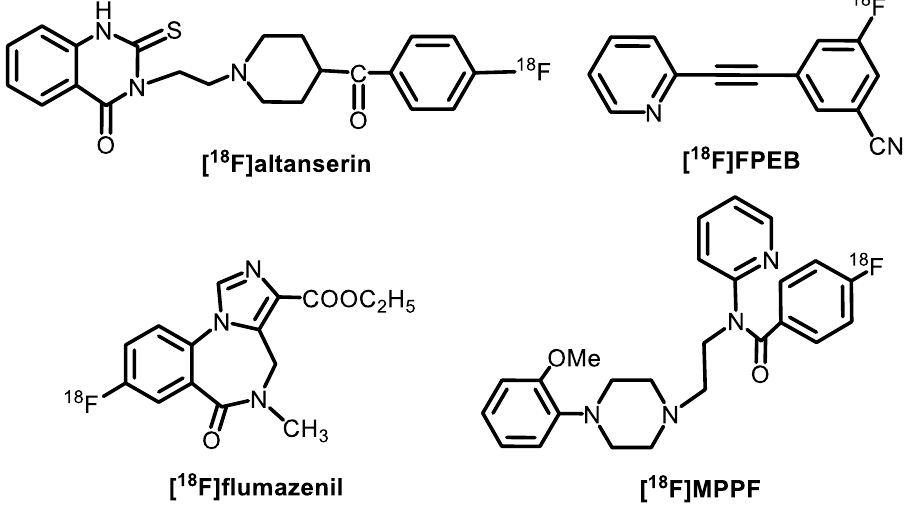
Figure 3. The structures of selected brain receptors radioligands prepared via conventional kryptofix-mediated aromatic nucleophilic radiofluorination of the appropriate nitro-precursors.